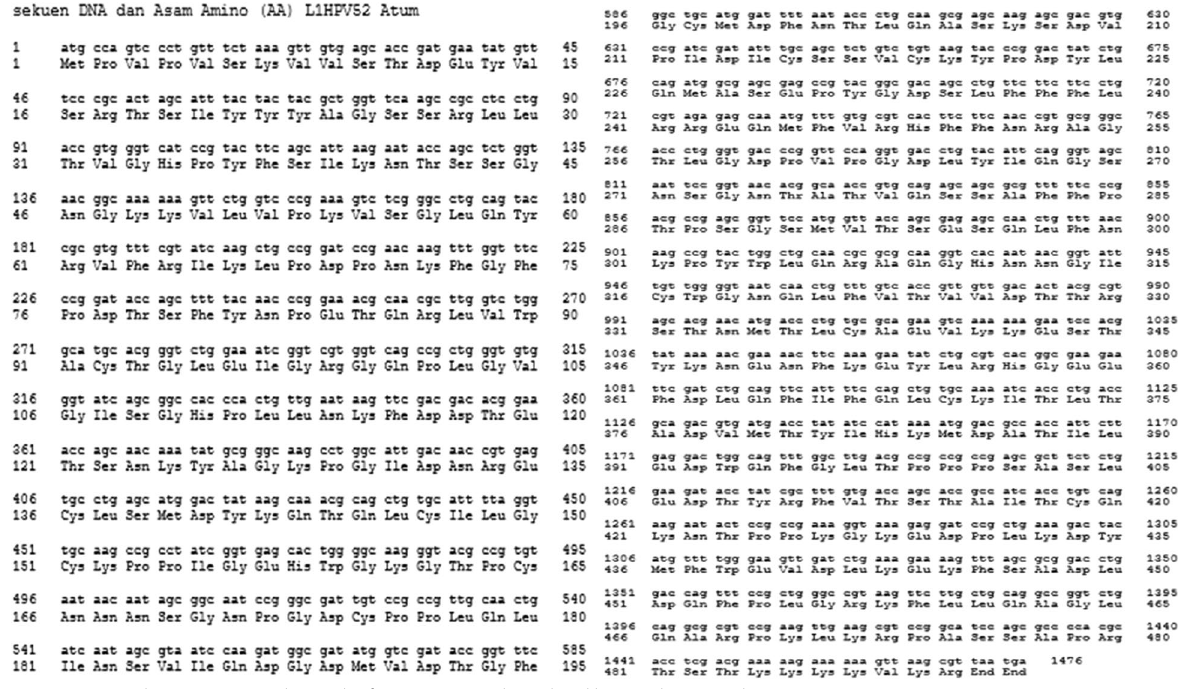
Fig. 10 DNA and aa sequence as the result of sequencing and translated by Bioedit v7.2 and ExPASy v4.1